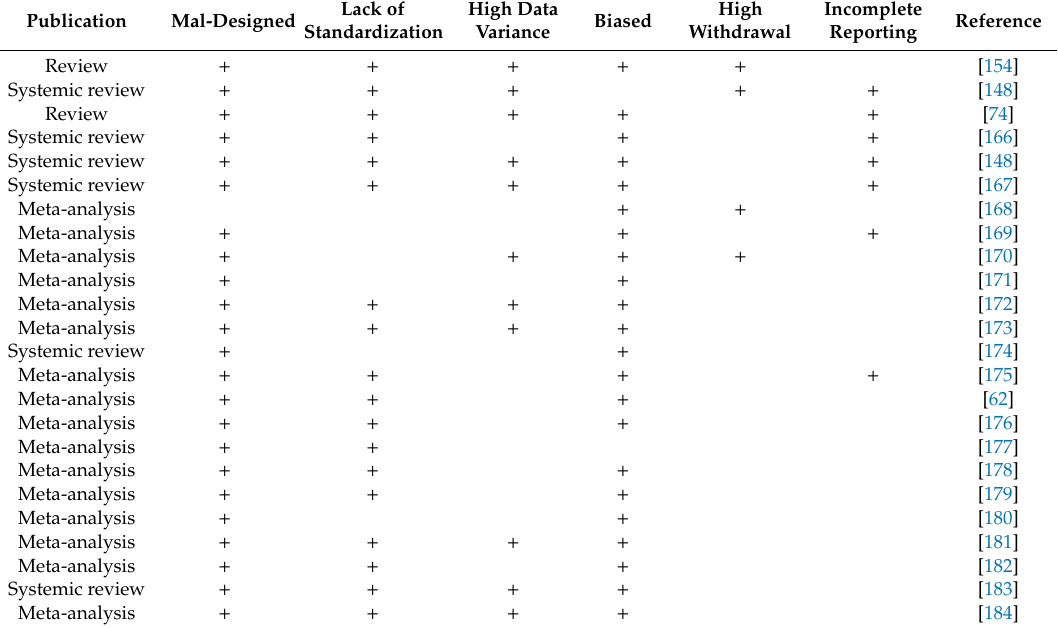
Table 3. A summary of recent meta-analyses and systemic reviews criticizing microbiome and probiotic